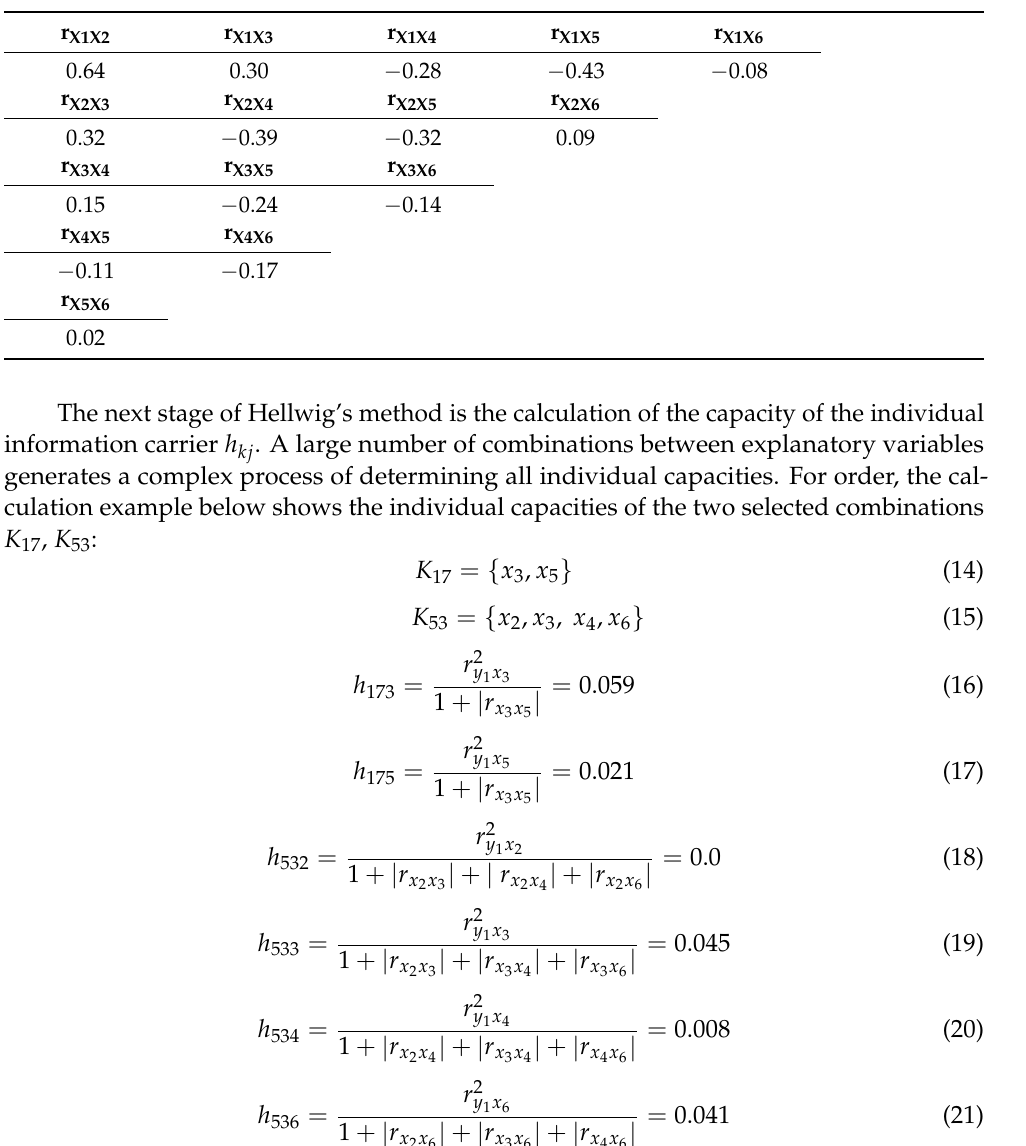
Table 5. Comparison of correlation coefficients values r j